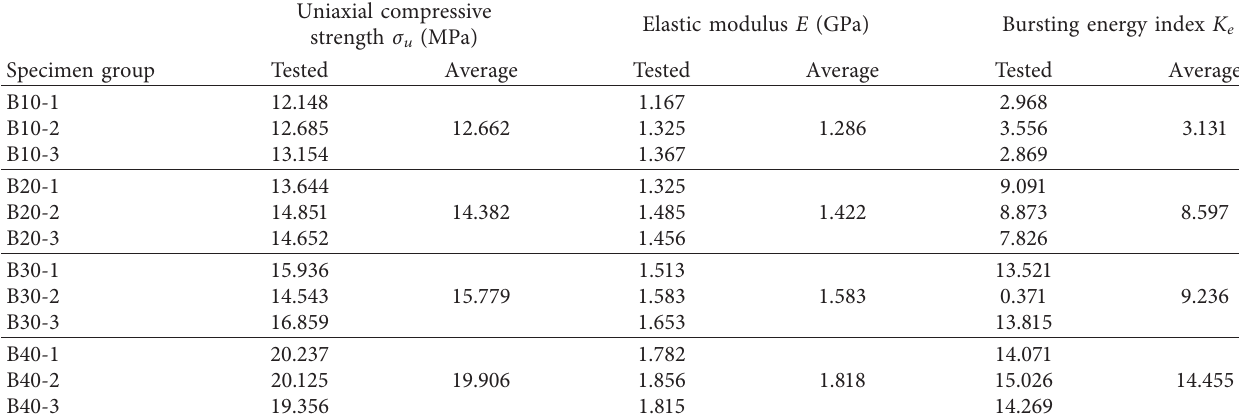
Figure 13: Test results of the mechanical parameters of composite specimens with different thicknesses. (a) Uniaxial compressive strength. (b) Elastic modulus. (c) Bursting energy index. Table 2: Mechanical parameters of composite specimens with different